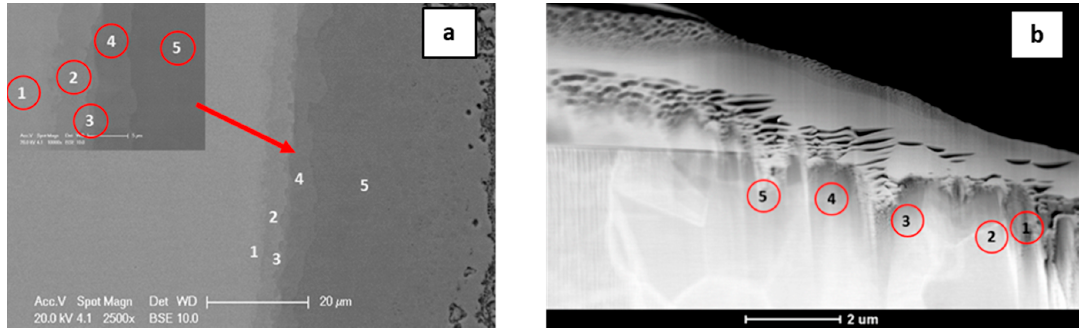
Figure 11. SEM ( a ) and TEM ( b ) microstructures of a Ni/Al/Ni interconnections (Ni substrate of B-type) after 3 h of reaction time at 720 °C with indicated EDS point analysis presented in Table 4. Numbers 1–5 denote particular intermetallic phases: 1-Ni solid solution, 2-AlNi 3 , 3-AlNi Ni-rich , 4-AlNi, 5-AlNi Ni-deficient .